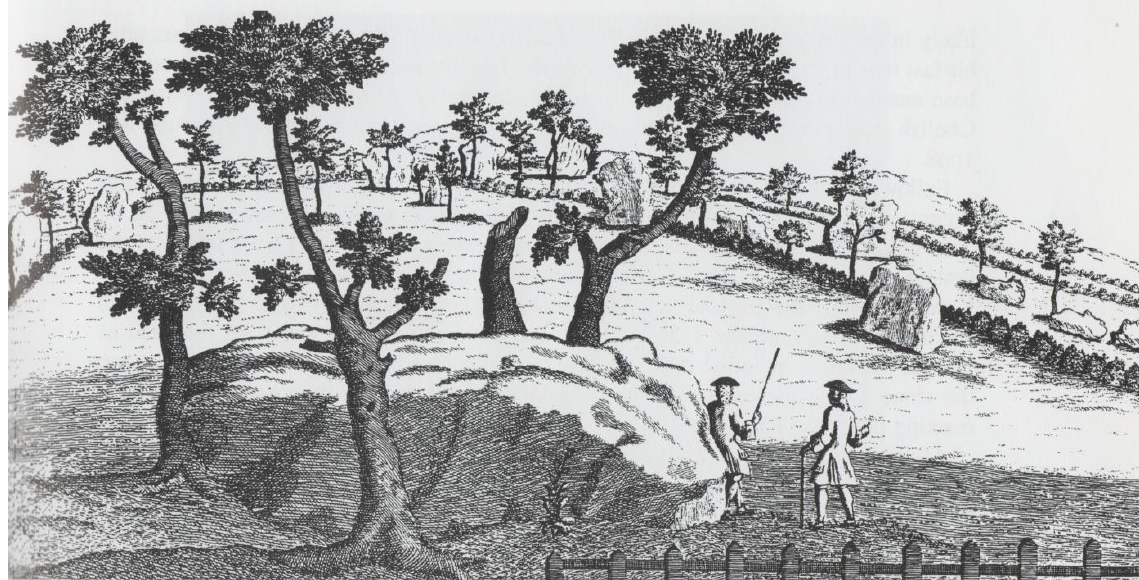
Figure 19. William Stukeley’s sketch of the Obelisk which he measured in 1723 as 21 feet in length. (Stukeley 1743: plate 16, facing p.